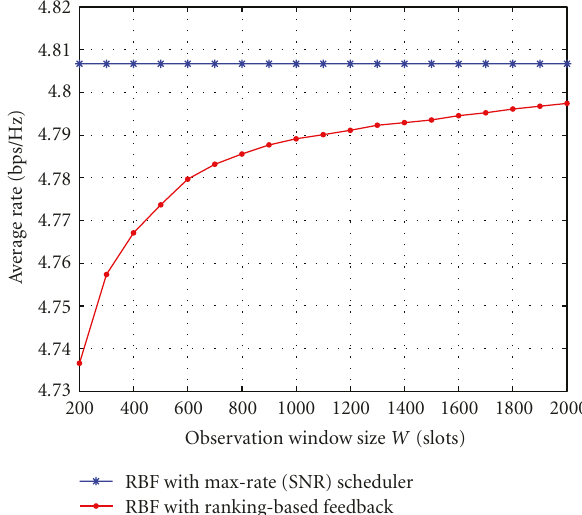
Figure 3: Average rate comparison as a function of window size W for single-beam RBF with M = 2 antennas, SNR = 10dB and K = 10 active users. User selection based on ranking-based feedback converges to capacity-optimal max-rate (SNR) scheduling for W →∞